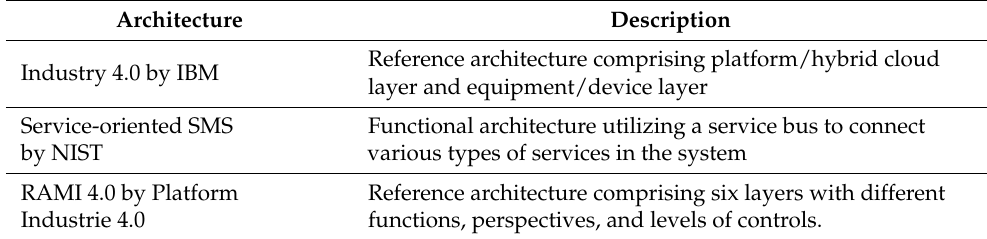
Table 2. Three representative architectures for